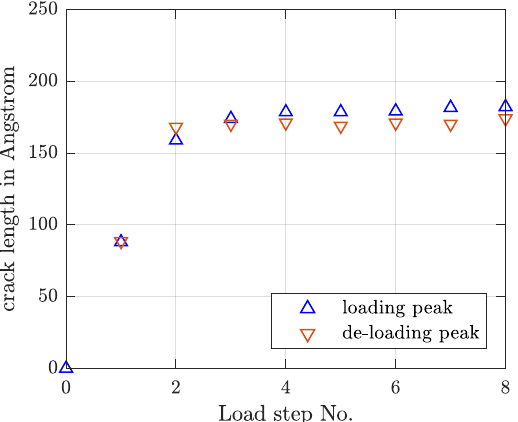
Figure 4. Evolution of the crack length. The blue signs indicate the peaks of the loading cycles, whereas the red triangles indicate the peaks of the unloading steps.